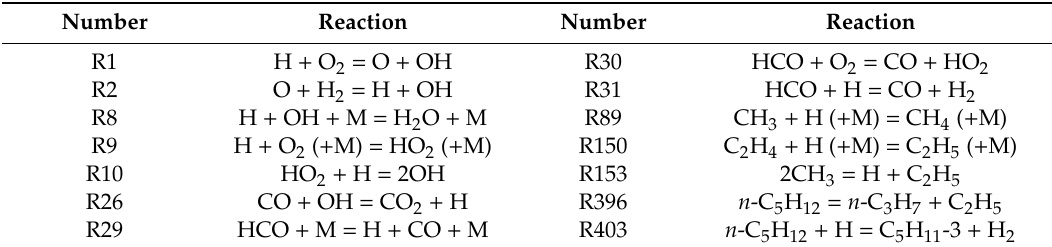
Table 1. The chemical reactions in the legend of Figure 5.